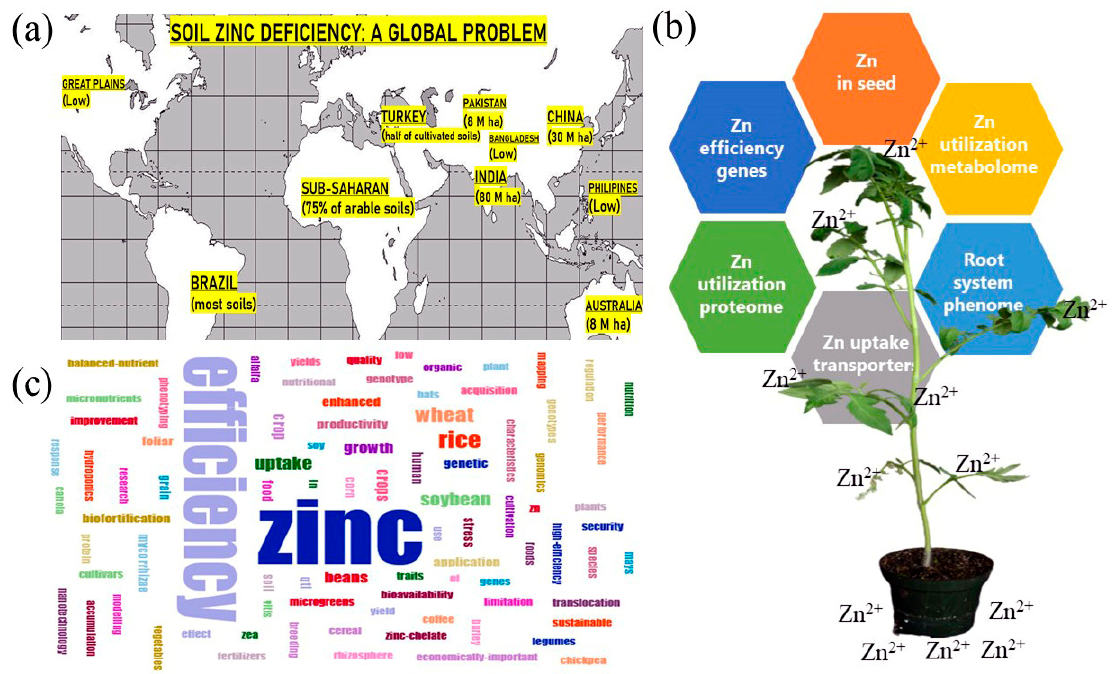
Figure 1. Overview of Zn deficiency and plant Zn efficiency. ( a ) Zn deficiency world map showing major countries and regions with low-Zn soils; ( b ) potential plant Zn efficiency approaches; and ( c ) word cloud of plant Zn efficiency keywords from the literature.